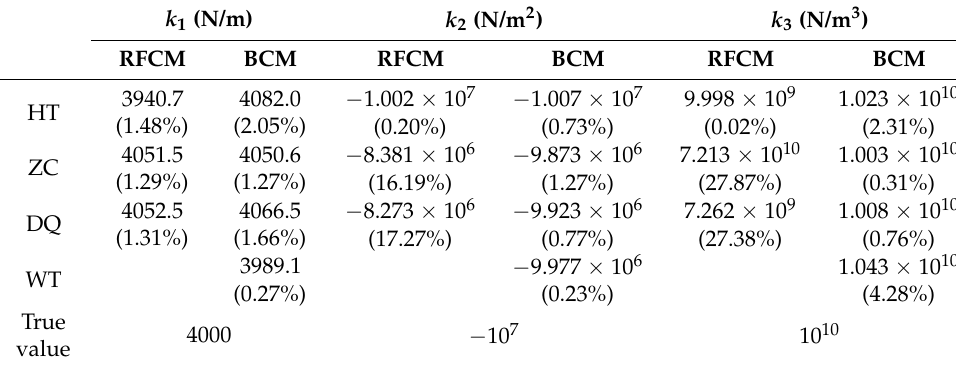
Table 1. Estimated results and errors of the stiffness parameters.